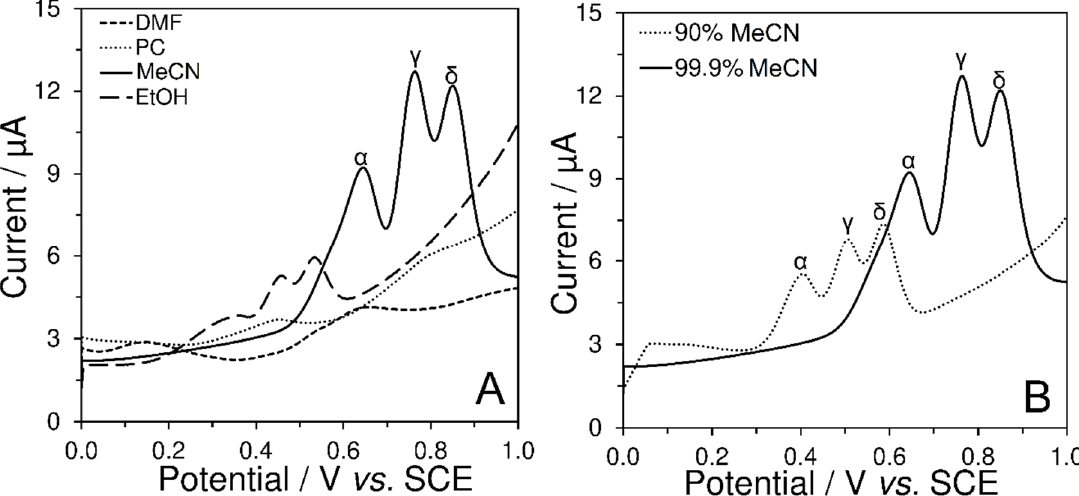
Figure 3. SWVs of 50 μ mol L − 1 tocopherols obtained at GCE in different organic solvents ( A ) and different content of water ( B ) containing 0.1 mol L − 1 LiClO 4 at E step = 1 mV, E ampl = 25 mV and f = 20 Hz, the potential was scanned from 0.0 to 1.0 V.